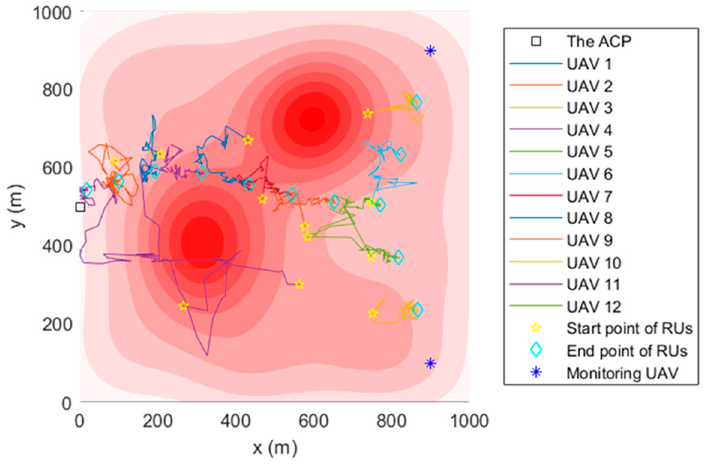
t . Figure 4. UAVs’ topology using TA&CRFO algorithm at t i . i